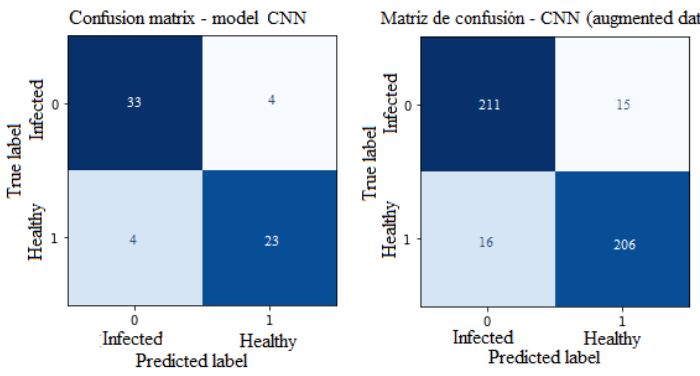
Figure 11. Confusion Matrices of the CNN Models.